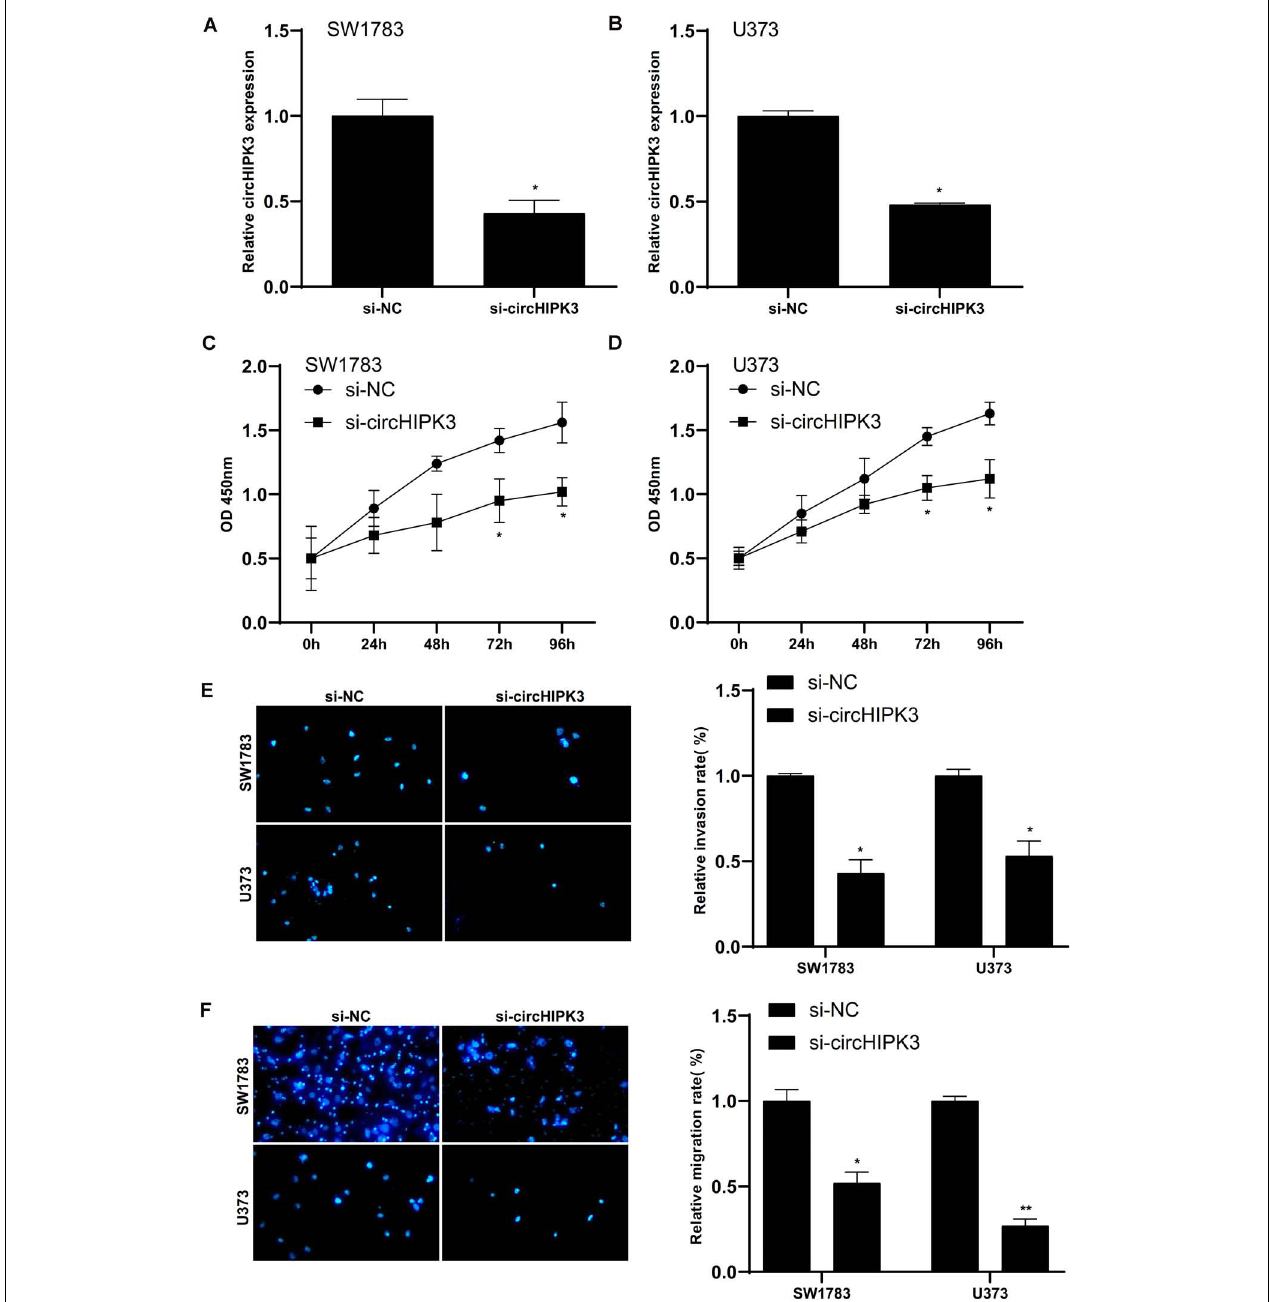
FIGURE 5 | Silencing of circHIPK3 suppressed glioma cells proliferation, invasion and migration. (A,B) Silencing efficiency of small interfering RNA against circHIPK3. (C–F) CircHIPK3 knockdown markedly suppressed the cell proliferation (C,D) , invasion (E) and migration (F) of glioma cells. ∗ p < 0.05, ∗∗ p <